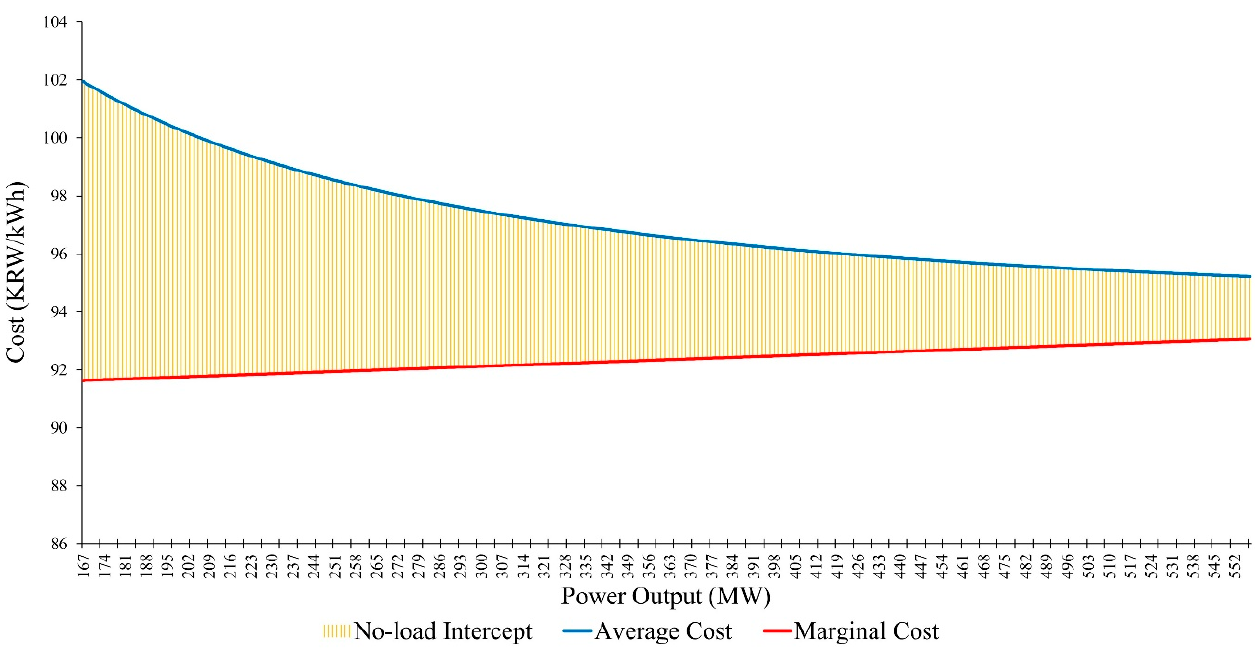
Figure 1. Comparison of average cost and marginal cost by power output.